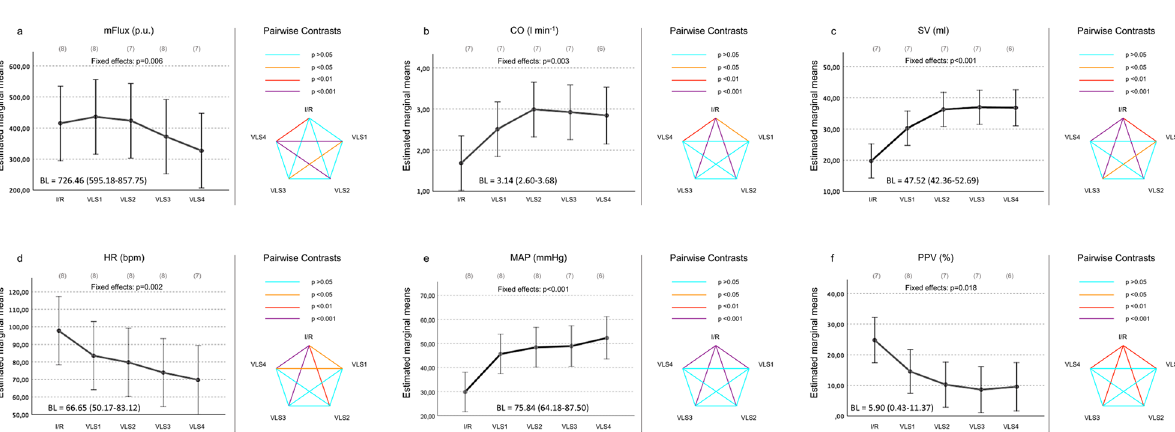
Figure 3. Changes of hemodynamic parameters throughout the experimental protocol. Changes throughout the experimental protocol of ( a ) mean microcirculatory blood flow (mFlux), ( b ) cardiac output (CO), ( c ) stroke volume (SV), ( d ) heart rate (HR), ( e ) mean arterial pressure (MAP) and ( f ) central pulse-pressure-variation (PPV). Data are presented as baseline adjusted estimated marginal means with 95% confidence intervals (left side). Results of pairwise comparisons are illustrated with color-coding of significance (right side). Points of measurements are 6 h after ischemia/reperfusion (I/R), volume loading steps 1–4 6 h after ischemia/reperfusion (VLS1-4). Number of valid values for each point of measurement are given in brackets. Baseline values (BL) prior ischemia/reperfusion are given in